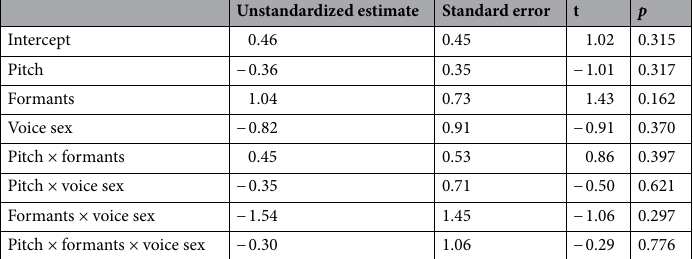
Table 3. Results of regression analysis of Valence PC scores in Study 1.